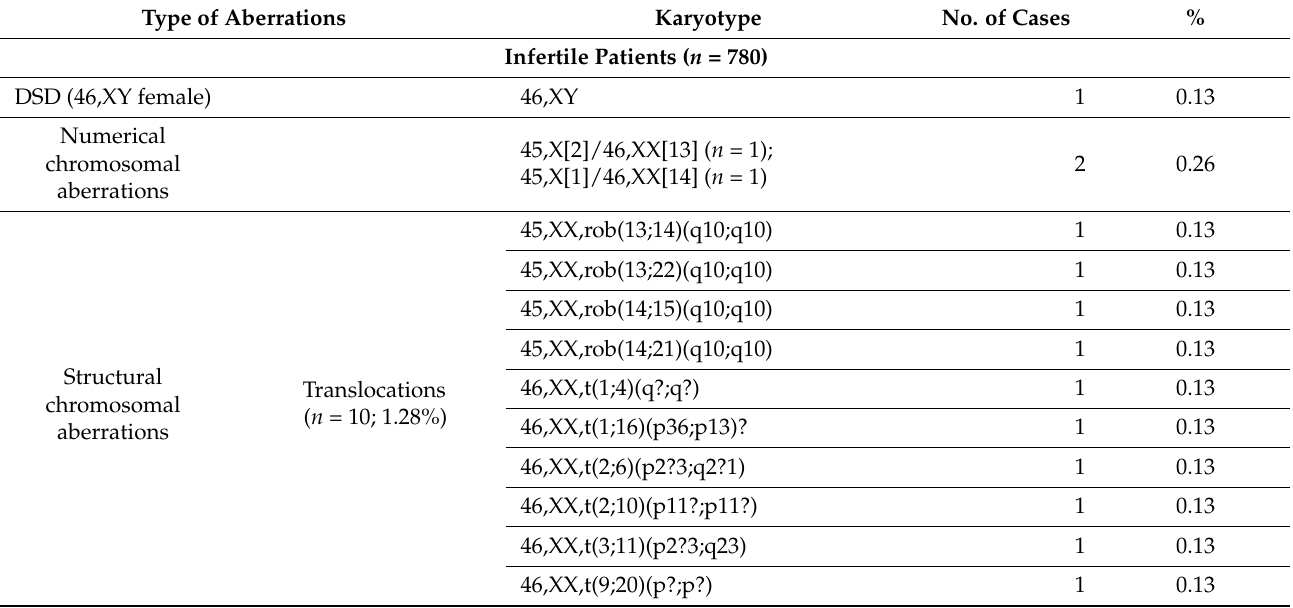
Table 2. Chromosomal abnormalities in infertile female patients and